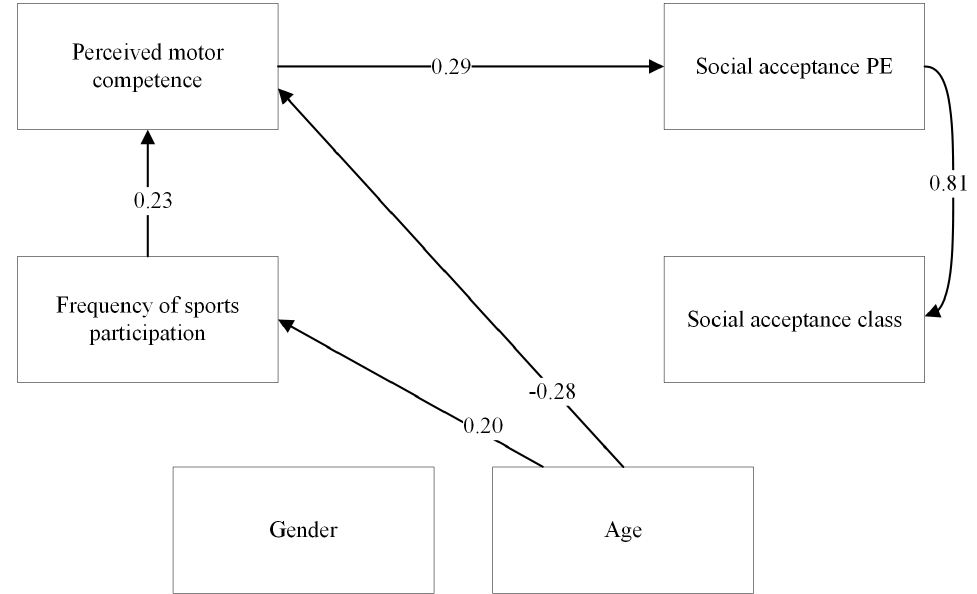
Figure 3. SEM model presenting significant paths between independent and dependent variables for children participating in individual sports. Standardised path coefficients (betas) are presented in the Figure.